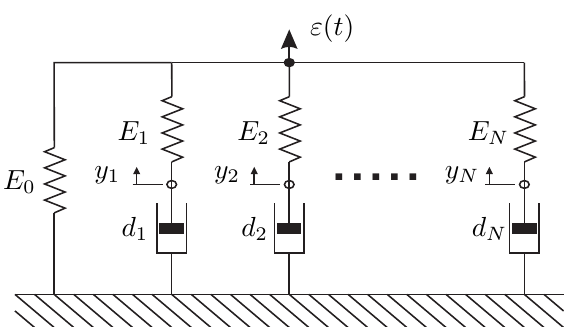
Figure 2. M AXWELL -Modell of the viscoelastic materials dynamic behavior representing one viscoelastic ring support.